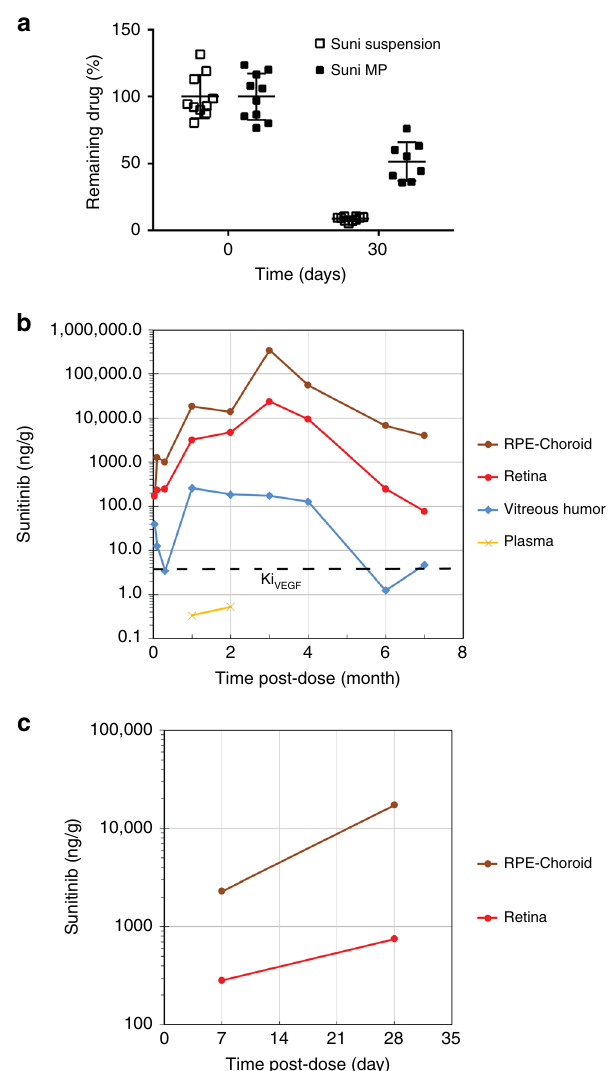
Fig. 7 Pharmacokinetic pro fi les of sunitinib MPs. a C57BL/6 mice were given a 1 µ l intravitreous injection of either MPs containing 1 µ g sunitinib (closed bar) or an equivalent dose of sunitinib drug suspension (open bar) in both eyes. Immediately after injection or at 30 days after injection, 5 mice from each condition were euthanized, and the amount of sunitinib remaining in the eyes was evaluated by a validated extraction and the LC – MS method and presented as a percentage of the initial dose. b A 50 µ l suspension of sunitinib MPs containing 1 mg sunitinib was administered to both eyes of pigmented New Zealand rabbits. After 500 μ L of blood was collected, animals were euthanized and the eyes were enucleated immediately after sacri fi ce. Central region RPE-choroid, retina, and vitreous humor in one eye of each animal were collected for pharmacokinetic ocular tissue analysis at 24 h, Days 3 and 10, and Months 1 – 4, 6, and 7. N = 4 biologically independent samples for time points through 4 month, n = 2 for 6 months, and n = 1 for 7 months. c A 200 µ l suspension of sunitinib MPs containing 2 mg sunitinib was administered to both eyes of pigmented New Zealand rabbits. Central region RPE-choroid and retina in one eye of each animal were collected Days 7 and 28 ( n = 3 biologically independent samples for each tissue at each time point). Sunitinib levels in plasma and ocular tissues were evaluated by LC – MS. Source data are provided as a Source Data fi